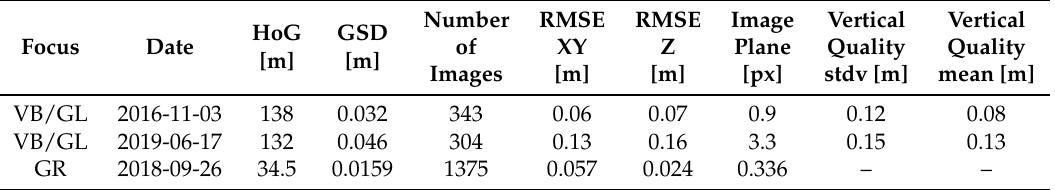
Table 4. UAV based surveys for the focus of proglacial river (GR) and valley-bottom/glacier lake assessment (VB/GL). Information about the height over ground (HoG), ground sampling distance (GSD), number of images, the root mean square error (RMSE) in both the horizontal plane (xz) and the vertical plane (z), as well as vertical quality of the DTM are indicated.